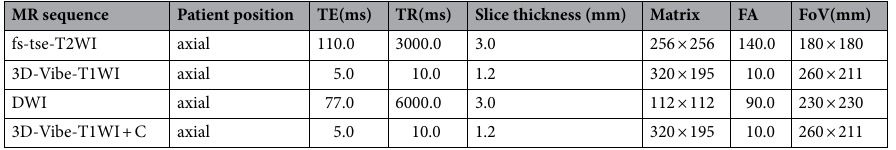
Table 1. MR scanning and sequence parameters. TE echo time; TR repetition time; FA flip angle; FoV field of